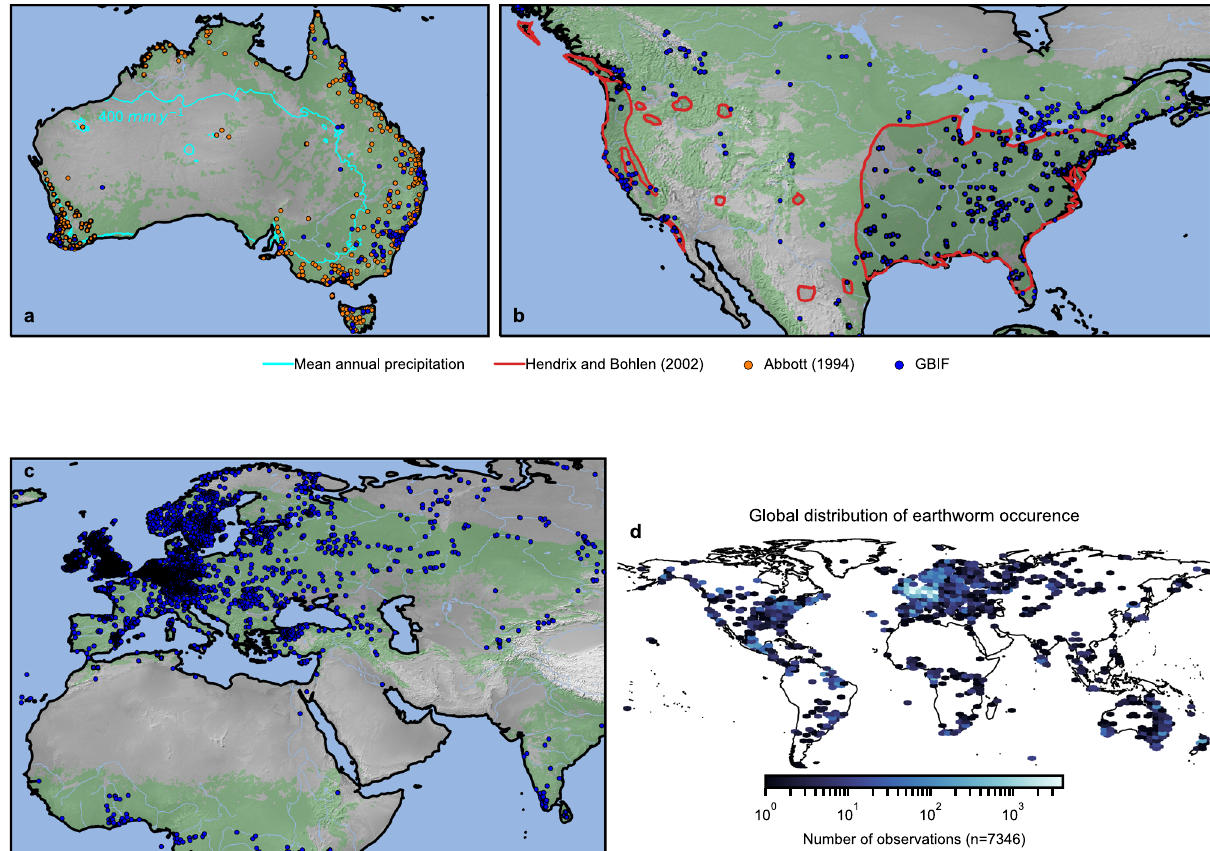
Fig. 3 Comparison of predicted hospitable zones and reported earthworm distribution. a Potential earthworm habitats (green) including soil hydromechanical limitations for Australia. Locations with reported presence of earthworms from two datasets are displayed; GBIF (blue points) and Abbott 15 (orange points). Regional limitation of earthworm activity is delineated by 400 mm yr − 1 of mean annual precipitation 48 (cyan contour) as previously reported 15 . b Predicted earthworm habitats for North America. Observed occurrences (Global Biodiversity Information Facility, GBIF) are in good agreement with regional extents of earthworm communities (redrawn from Hendrix and Bohlen 16 , red). c Regions in East Eurasia and Northern Africa that could support earthworm soil bioturbation. d Global distribution of earthworm occurrence. Made with Natural Earth. Free vector and raster map data @